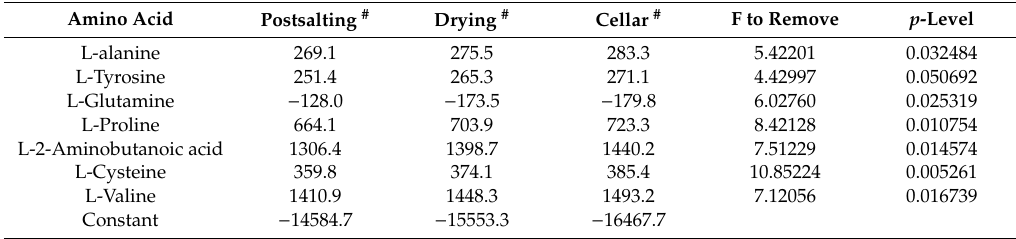
Table 7. Results of the stepwise